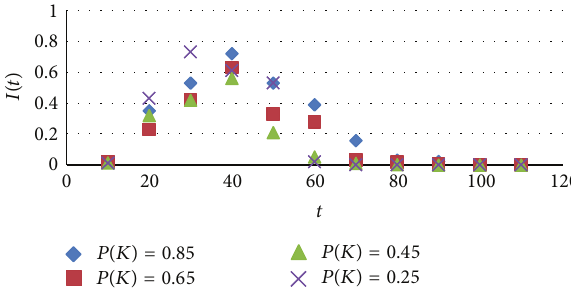
Figure 6: Frequency of contact impact on information dissemina- tion.